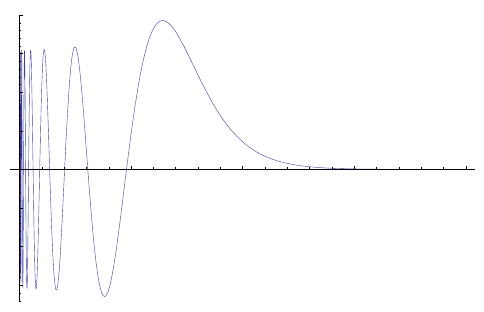
Figure 9 . K i! ( x ) oscillates wildly as (cid:24) e i! ln( x ) for small x